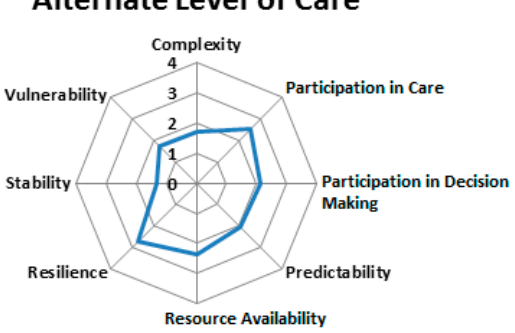
Figure 3. Spider Chart of Mean Synergy Scores for Patients on the HHSC Alternate Care Level Unit.